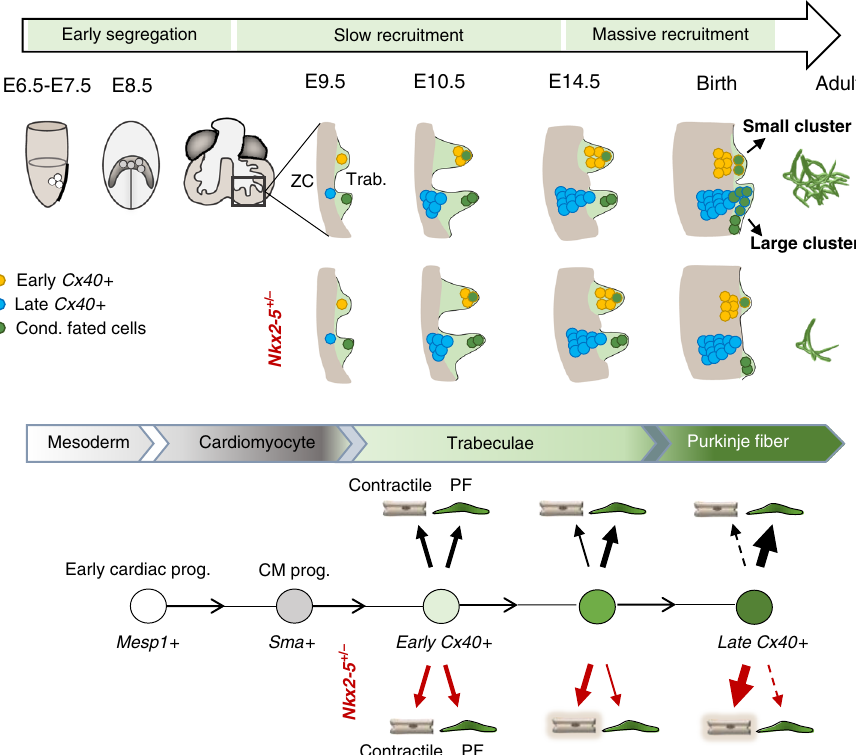
Fig. 5 Model of the Purkinje fi ber lineage segregation and temporal requirement of Nkx2-5 during PF network morphogenesis. Scheme showing the contribution of progenitor cells at different developmental stages and their contribution to the PF network. In the gastrulating embryo, Mesp1 + progenitors into the cardiomyocyte lineage ( Sma + ) contribute to ventricular myocardium. From E7.5, a subset of progenitors is already fated to the conductive lineage (green cells). During trabeculation (Trab.), Cx40 + (yellow) cells contribute to small PF clusters with reduced proliferation building a polyclonal PF network. These Cx40 + cells give rise to both conductive and working lineages and are unaffected by reduced Nkx2-5 dosage. Cells from a highly proliferative progenitor subpopulation (blue) express Cx40 at later stages (from E10.5) as they are incorporated into trabeculae. These cells enter the conductive lineage at late fetal stage in a massive Nkx2-5- dependent recruitment to contribute to ellipsoidal structures of the PF network. In control mice the conductive potency of Cx40 + trabecular progenitors increases with time, whereas in Nkx2-5 + / − mice, the conductive potency is progressively lost leading to very rare large clusters and a hypoplastic PF network. ZC compact